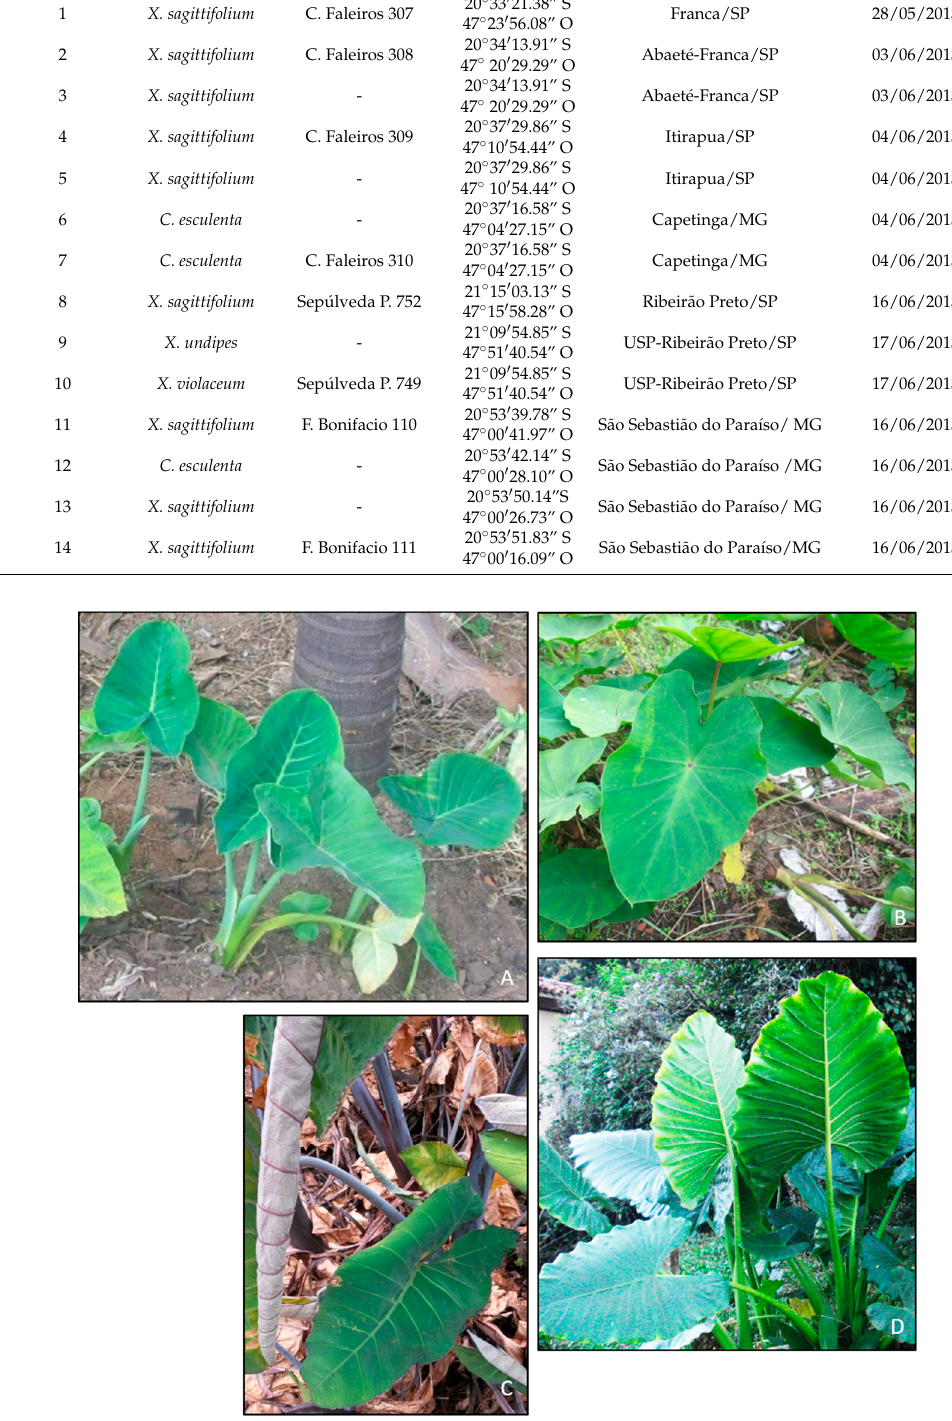
Figure 1. Images of populations of X. sagittifolium ( A ), C. esculenta ( B ), X. violaceum ( C ), and X. undipes ( D ), which correspond to samples 11, 12, 10 and 9, respectively (Source: Laboratory of Plant